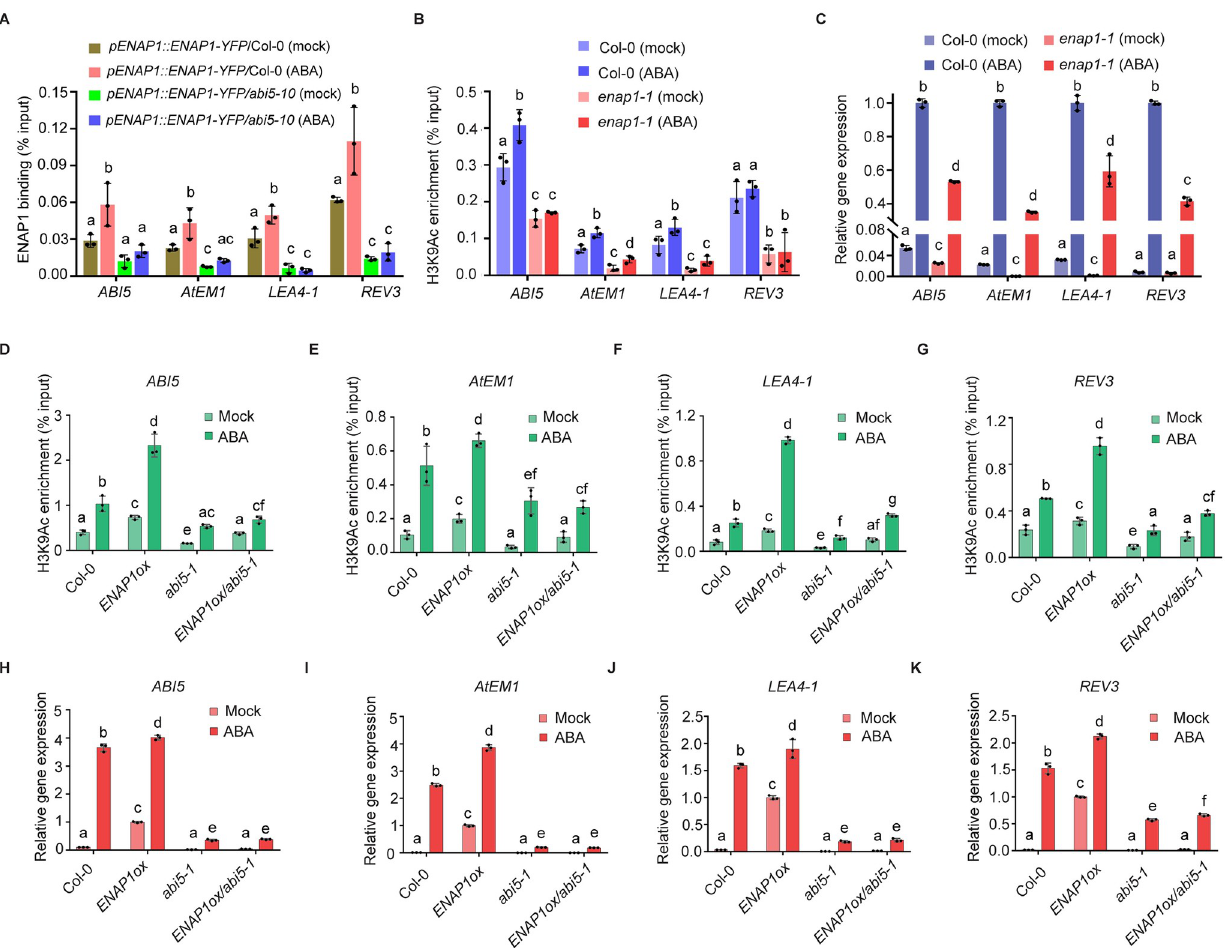
Fig 5. ENAP1 depends on ABI5 to regulate H3K9Ac in response to ABA during seed germination. ( A ) ChIP-qPCR to show ENAP1 binding to the promoters of four representative ENAP1 and ABI5 co-targeted genes. 24h germinated seeds of indicated plants under mock and 2uM ABA treatment were used for the ChIP assay. ( B ) ChIP-qPCR to examine H3K9Ac enrichments in the promoters of the target genes. Col-0 and enap1-1 seeds that were germinated for 24h in the presence of mock or 0.5 μ M ABA were used for the ChIP assay. ( C ) qRT-PCR to show target genes’ expression in seeds of Col-0 and enap1-1 . Total RNAs were extracted from seeds treated as described in ( B ). ( D-G ) ChIP-qPCR to examine H3K9Ac enrichment in the promoters of ABI5 ( D ), AtEM1 ( E ), LEA4-1 ( F ) and REV3 ( G ). ChIP assay was performed with anti-H3K9Ac antibody in Col-0, ENAP1ox , abi5-1 and ENAP1ox/abi5 seeds that were germinated for 24h with mock or 2 μ M ABA treatment. ( H-K ) qRT-PCR analysis of the relative expression of ABI5 ( H ), AtEM1 ( I ), LEA4-1 ( J ) and REV3 ( K ). Total RNAs were extracted from seeds treated as in ( D ). All data represent means ± s.d. of three replicates. Different letters represent significant differences with P < 0.05 in the one-way ANOVA test.